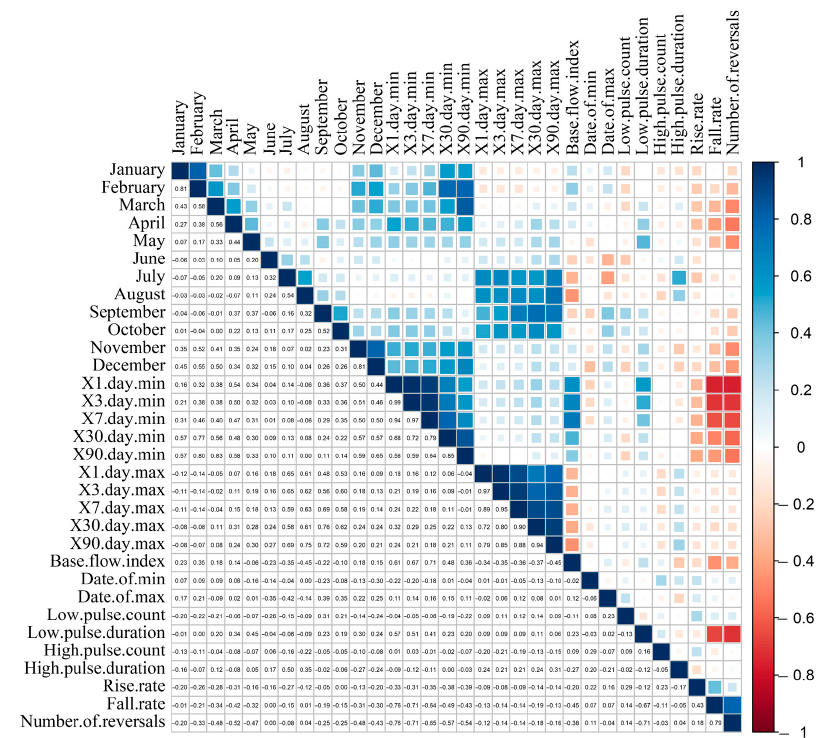
Figure 3. Thermodynamic diagram of the IHA index correlation.